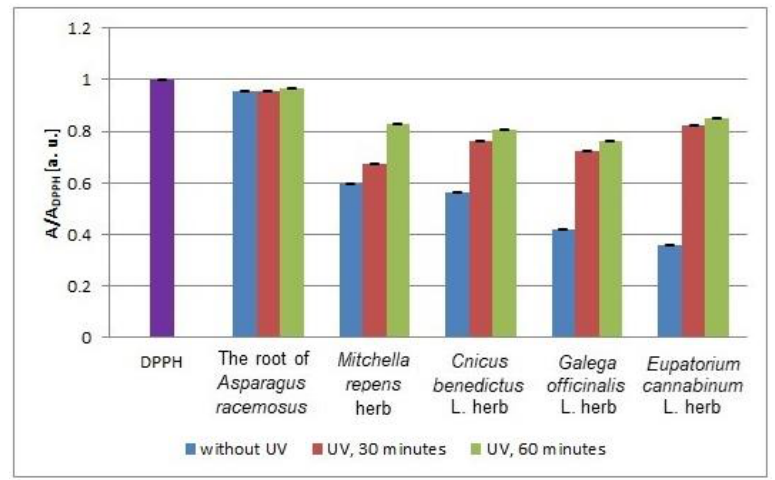
Figure 10. Comparison of the relative amplitudes (A/A DPPH ) [±0.02 a. u.] of the EPR spectra of DPPH free radicals interacting with the infusions of the root of Asparagus racemosus and Mitchella repens herb, Cnicus benedictus L. herb, Galega officinalis L. herb, and Eupatorium cannabinum L. herb for 12 min. A—amplitude of the EPR line of DPPH free radicals in contact with the tested samples. A DPPH — amplitude of the EPR line of DPPH free radicals in the reference solution. For the reference solution, the relative amplitude (A/A DPPH ) takes a value of 1. Data for the infusions obtained from the plant materials exposed to UVA radiation for 30 and 60 min. Data for the infusions of the plant material that was not exposed to UVA radiation are also given.